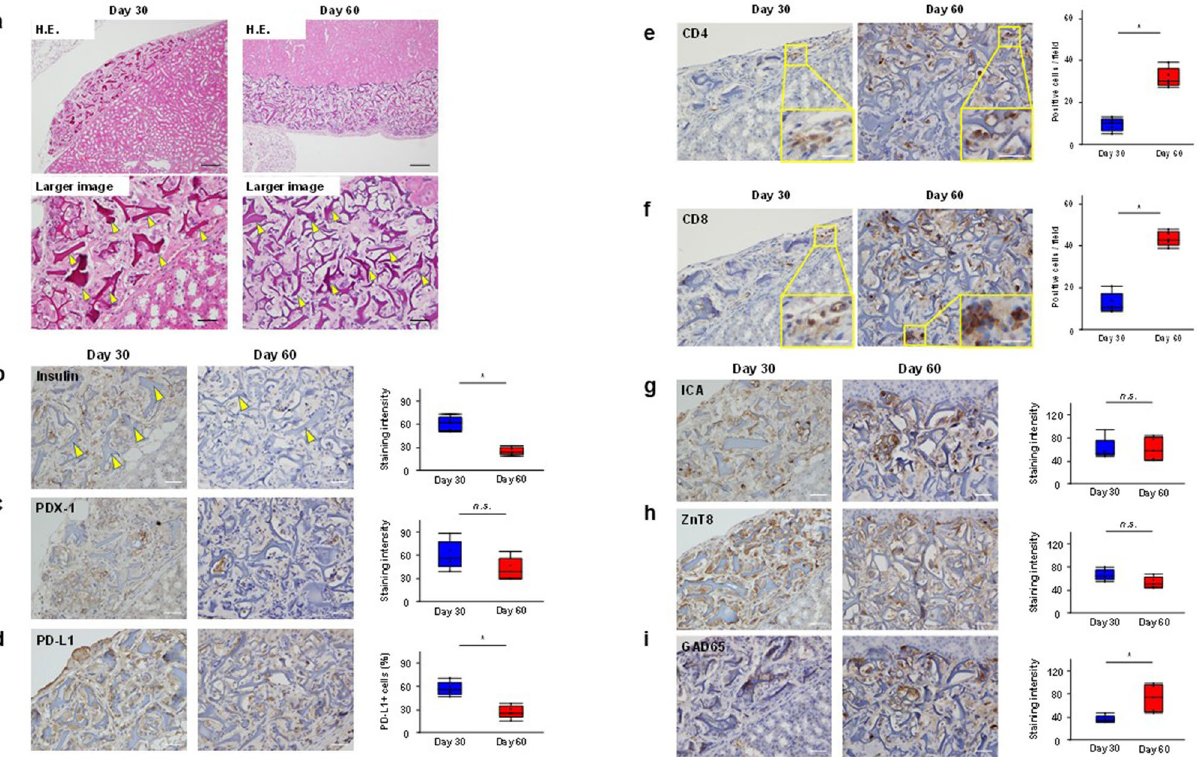
Figure 4. Pathological examination of the transplanted NOD-IPCs. ( a ) H&E-stained transplanted NOD- IPCs were examined under the kidney capsule. RCP μ-pieces were identified at the indicated time points (yellow arrowheads). Upper panels. Original magnification, × 100. Scale bar, 200 μm. Lower panels. Original magnification, × 400. Scale bar, 50 μm. ( b–d ) Immunohistochemical staining of the NOD-IPCs. These